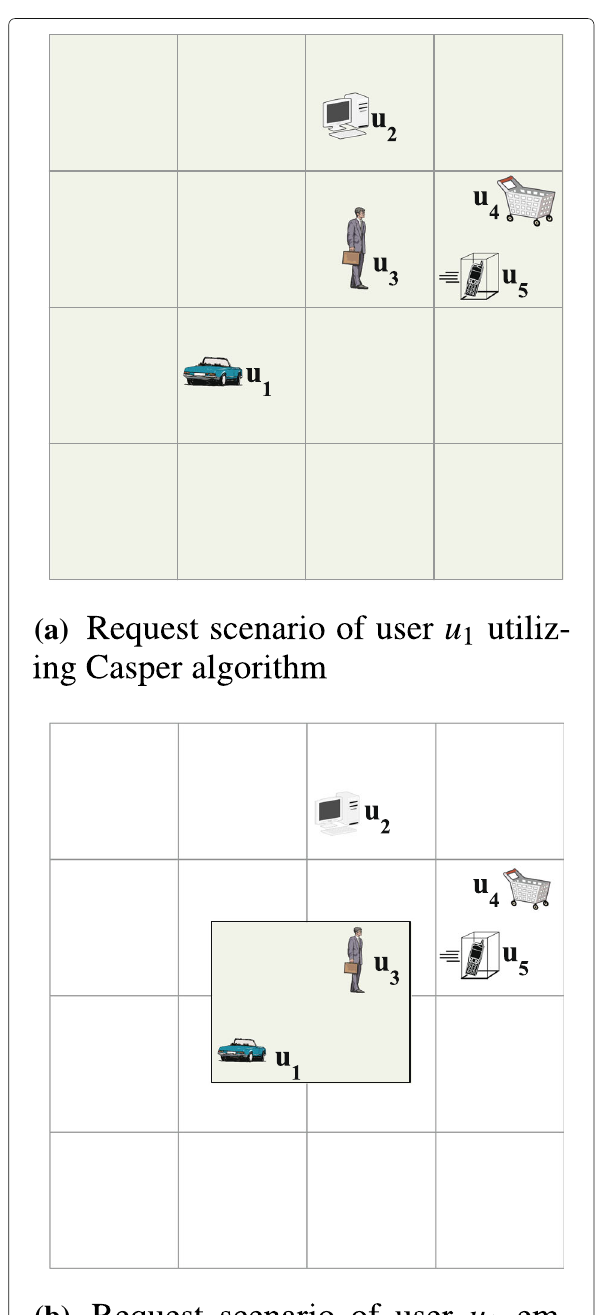
Fig. 6 Comparison of anonymous processes between Casper algorithm and K-DDCA algorithm. It depicts the anonymization process of the Casper algorithm and the K-DDCA algorithm. Subgraph a shows the Casper anonymous process, and subgraph b indicates the K-DDCA algorithm anonymous process. The shaded area represents the anonymous region. Assume that there is a LBS request req and k =